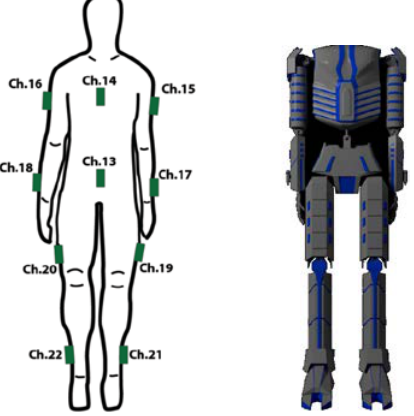
Figure 3. Placement and operating channels of the sensors with the character model created for the motion tracking game.